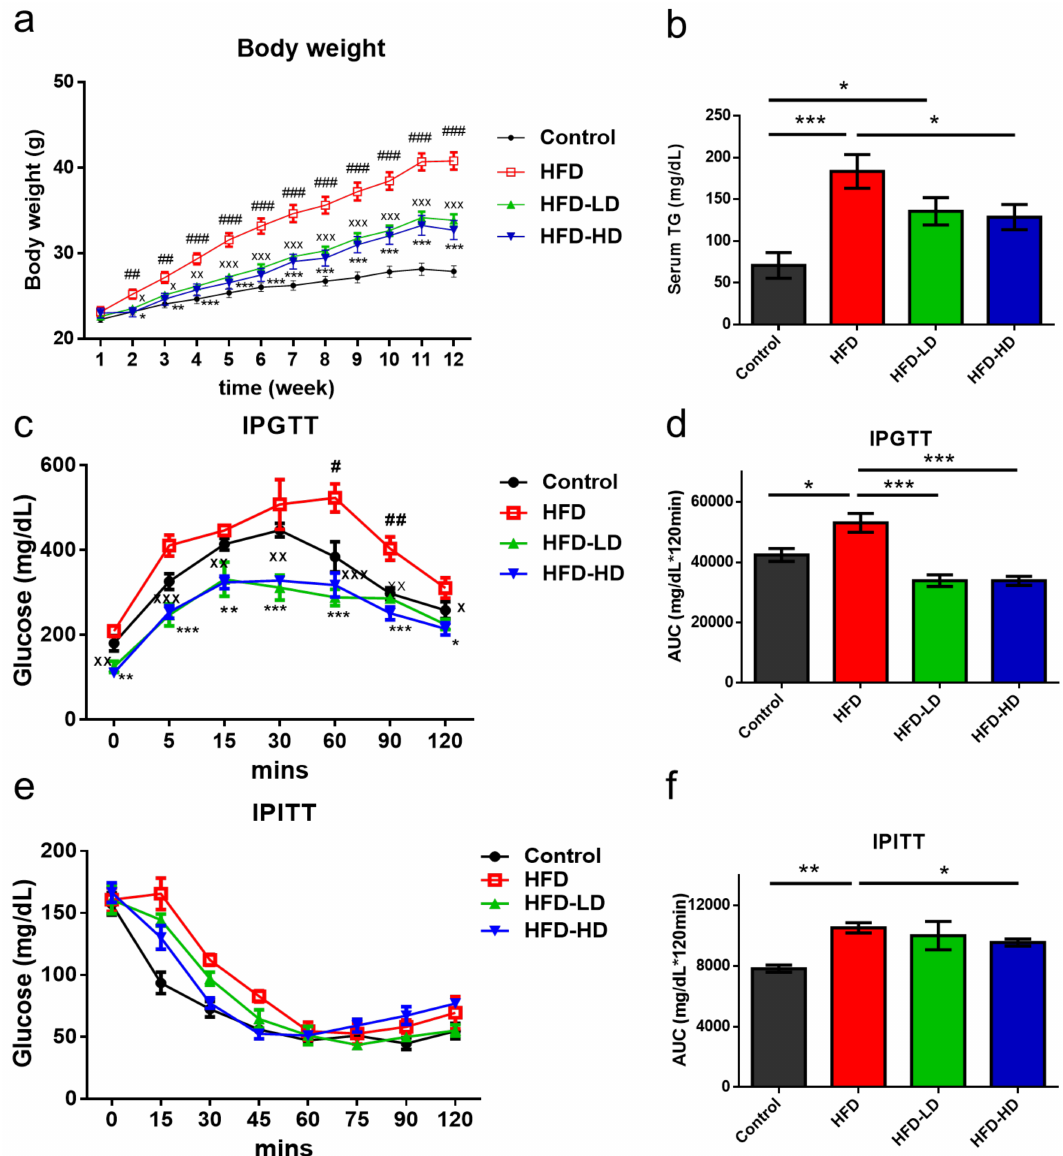
Figure 1. Empagliflozin attenuates metabolic parameters in HFD mice. ( n = 6). Six-week-old C57BL/6 male mice were fed a control diet (CD, 10% from fat), HFD (58% kcal from fat), HFD+ low-dose empagliflozin (3mg/kg BW), or HFD + high-dose empagliflozin (10mg/kg BW) for 12 weeks. ( a ) Empagliflozin significantly attenuates HFD-induced body weight gain at the end of the 12-week period, regardless of empagliflozin dosage. ( b ) High-dose empagliflozin significantly decrease serum triglyceride level. ( c , d ) Both high and low dose of empagliflozin improves glucose tolerance but only high dose of empagliflozin significantly improved insulin tolerance ( e , f ). The histograms represent mean ± standard error (SE). Statistical analysis was performed with one-way ANOVA. # p < 0.05, ## p < 0.01, ### p < 0.001, HFD vs. control; X p < 0.05, XX p < 0.01, XXX p < 0.001, HFD-LD vs. HFD; * p < 0.05, ** p < 0.01, *** p < 0.001 (HFD-HD vs. HFD in ( a , c ), other meaning the significance between groups). AUC, area under the curve; HFD, high-fat diet; LD, low-dose empagliflozin; HD, high-dose empagliflozin; IPGTT, intraperitoneal glucose tolerance test; IPITT, intraperitoneal insulin tolerance test; TG,